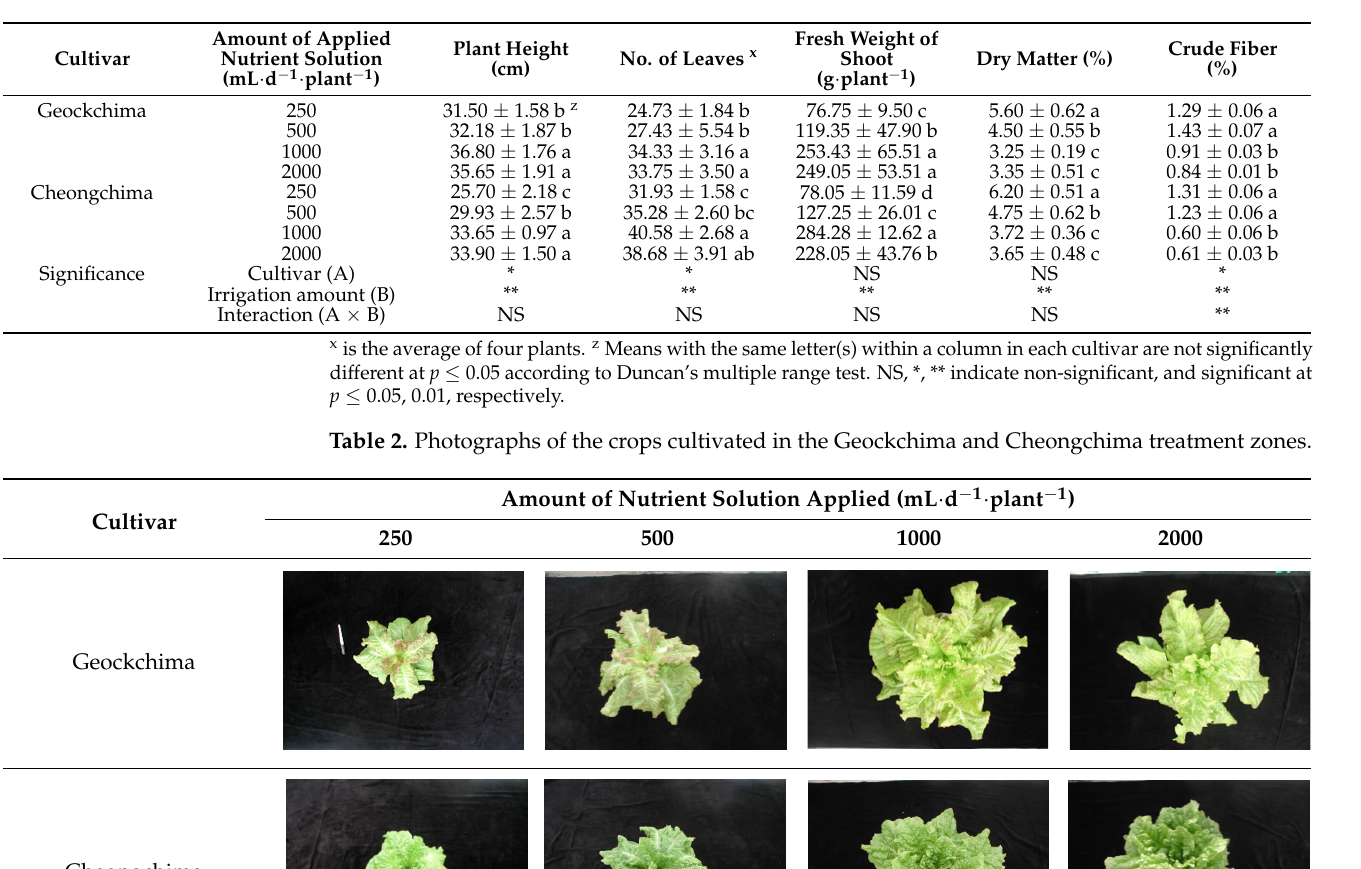
Table 1. Effects of the amount of applied nutrient solution on growth performance, dry matter, and crude fiber content of two leaf lettuce cultivars grown in perlite culture.